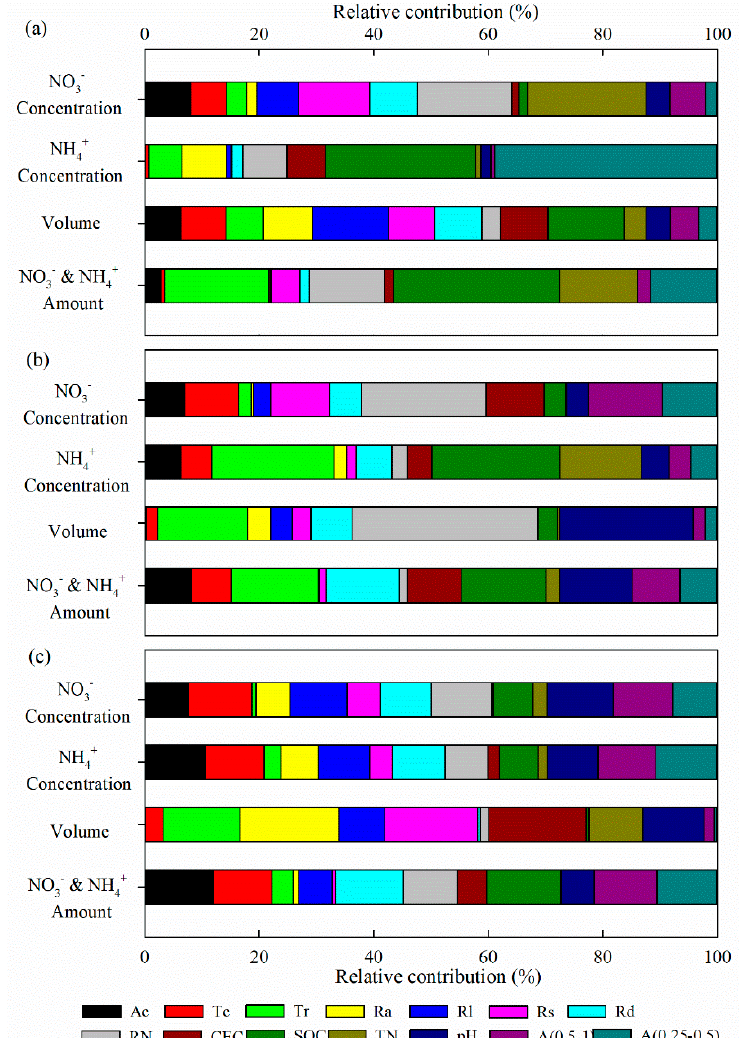
Figure 5. Relative contributions to data variability explanation of NO 3 − and NH 4+ concentrations, leaching volumes and the total amount of both forms at (a) low, (b) optimum and (c) high N level, by following variables: Ac, arbuscular colonization rate; Tc, total colonization rate; Tr, transpiration rate; Ra, root activity; Rl, root length; Rs, root area; Rd, root diameter; RN, root N concentration; CEC, cation exchange capacity; SOC, soil organic carbon; TN, soil total N concentration, A(0.5–1), 0.5–1 mm aggregates; A(0.25–0.5), 0.25–0.5 mm aggregates. n = 3.